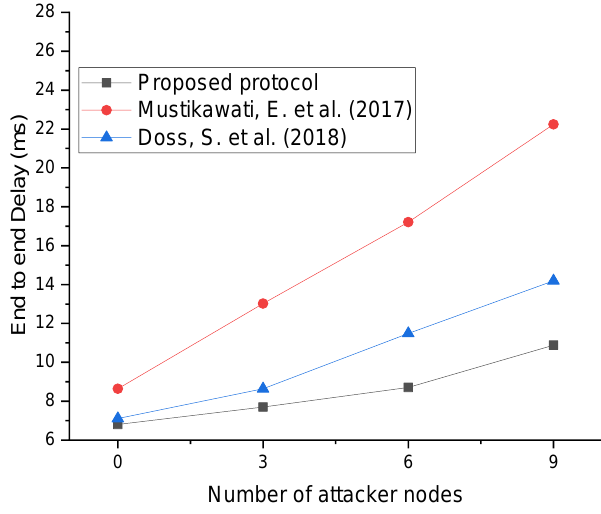
Figure 17. End-to-end delay under Jellyfish reordering attacks [20,37].